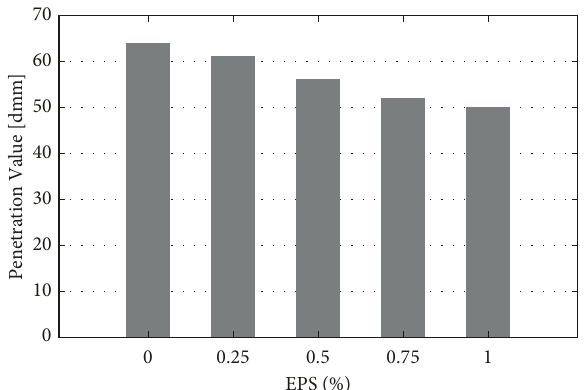
Figure 4: Experimental scheme.